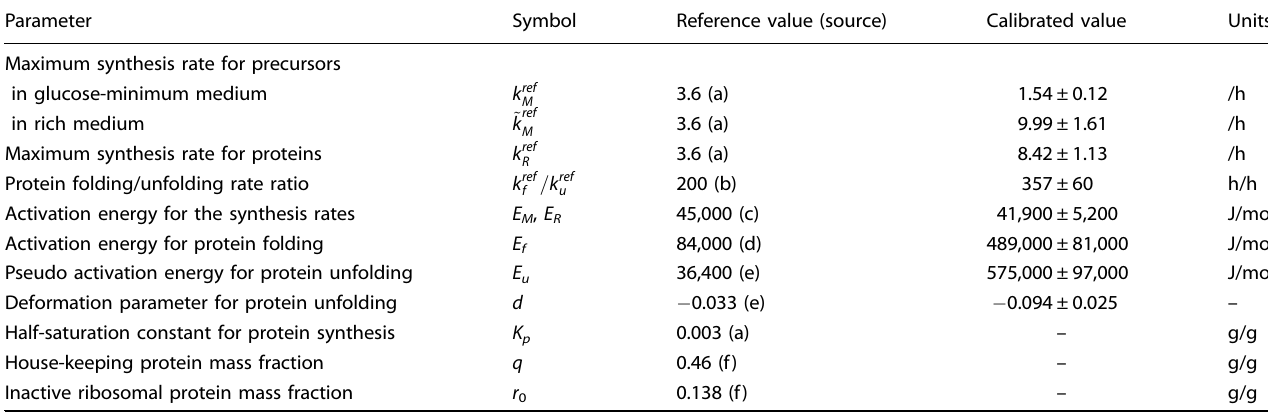
Table 2. Parameter values for the coarse-grained resource allocation